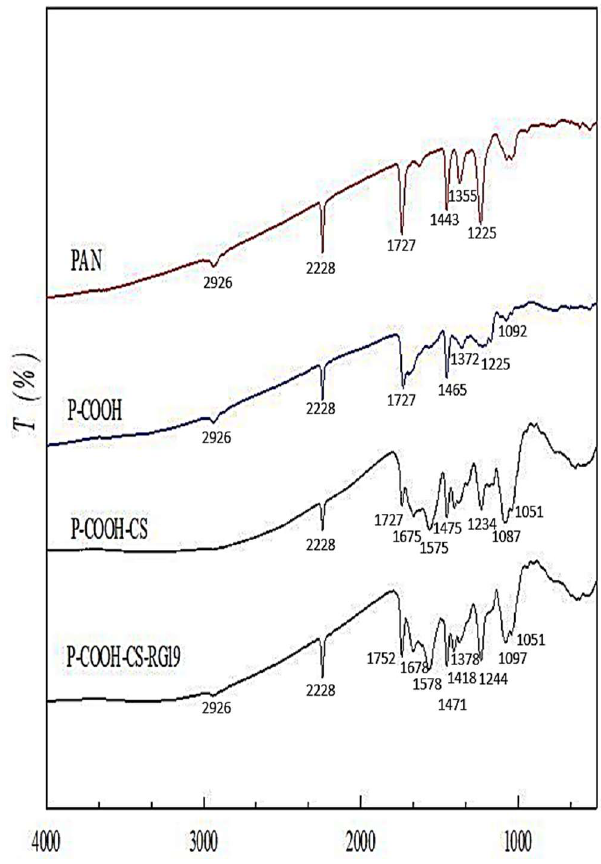
Figure 2. FTIR spectra of ( a ) PAN, ( b ) P-COOH, ( c ) P-COOH-CS, ( d ) P-COOH-CS-RG19.